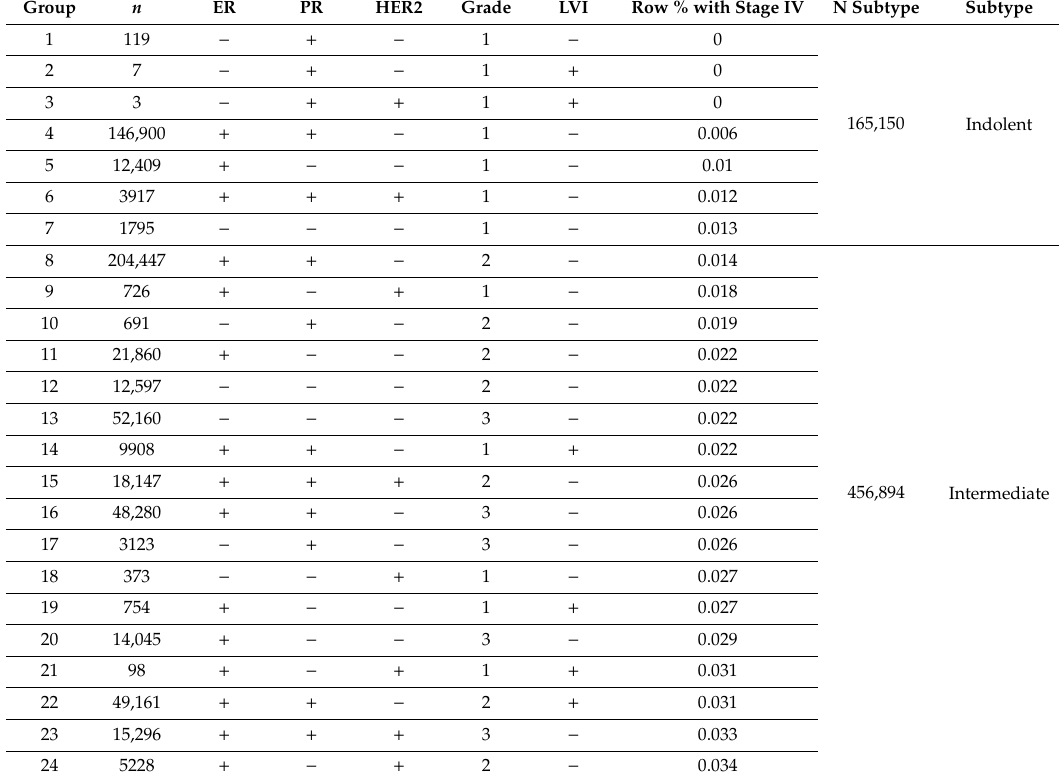
Table 1. Classification system of breast cancer biological subtypes. ER: estrogen receptor,